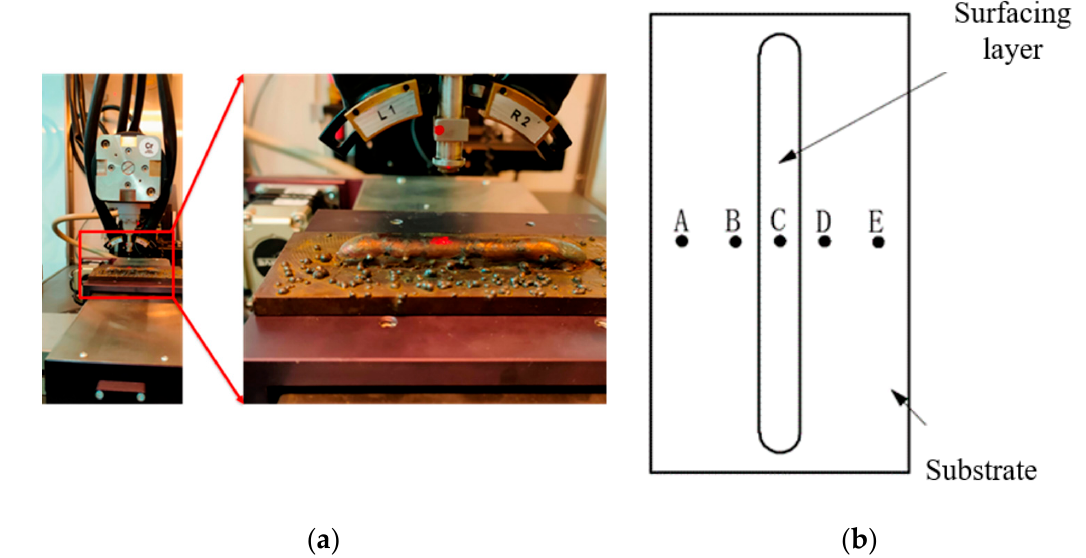
Figure 4. The residual stress detection diagram of surfacing parts obtained by experiment. ( a ) Physical image of residual stress detection. ( b ) Residual stress detection points of surfacing parts.